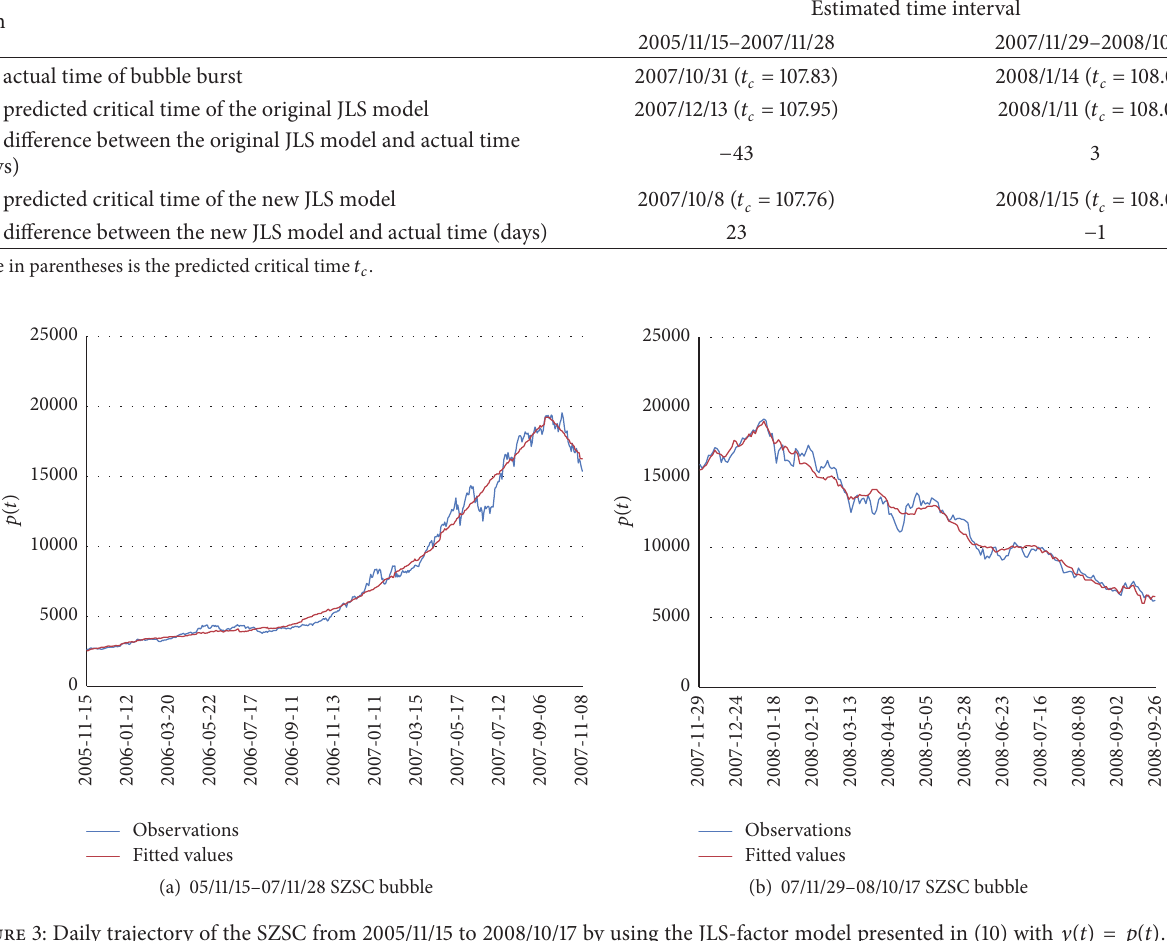
Table 3: Prediction of the critical time of the SZSC bubbles burst for both models and their differences with the actual times of bubble burst. Item